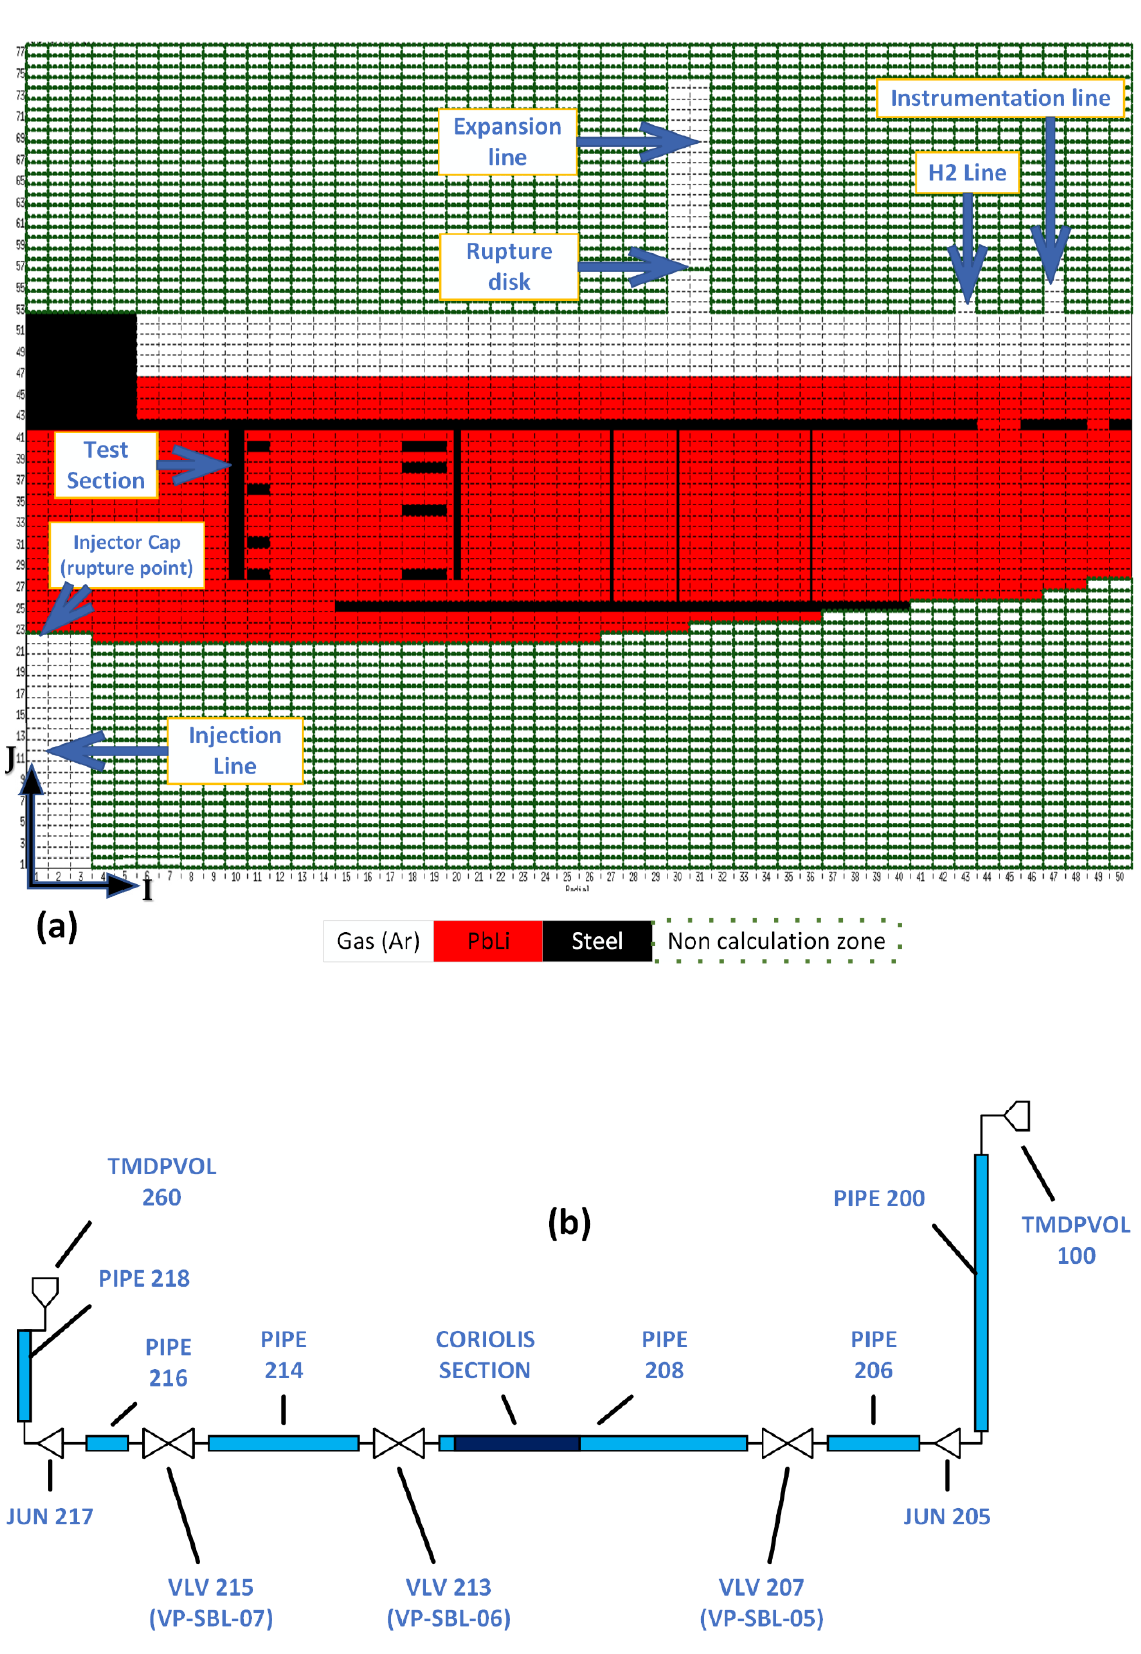
Figure 8. Detailed code nodalization. ( a ) SIMMER-III nodalization (not on scale) for LIFUS5/Mod3 facility, used in Standalone and coupled analysis; ( b ) RELAP5/Mod3.3 nodalization of the injection line (only pipe lengths on scale).